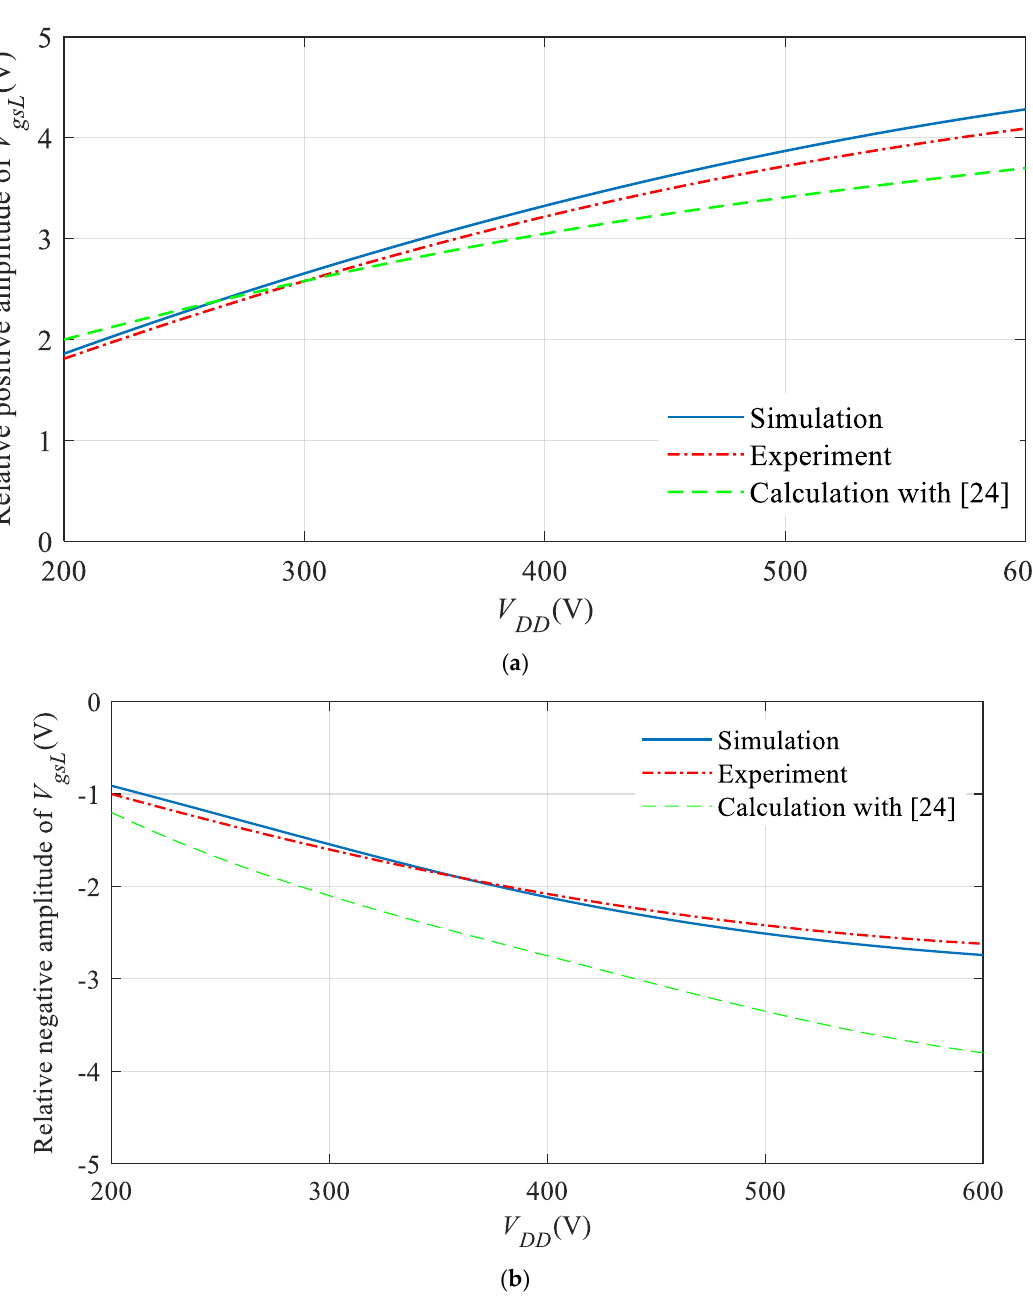
Figure 24. Comparison of simulation and experimental variation trend of relative crosstalk peak value with different V DD . ( a ) turn-on. ( b ) turn-off.